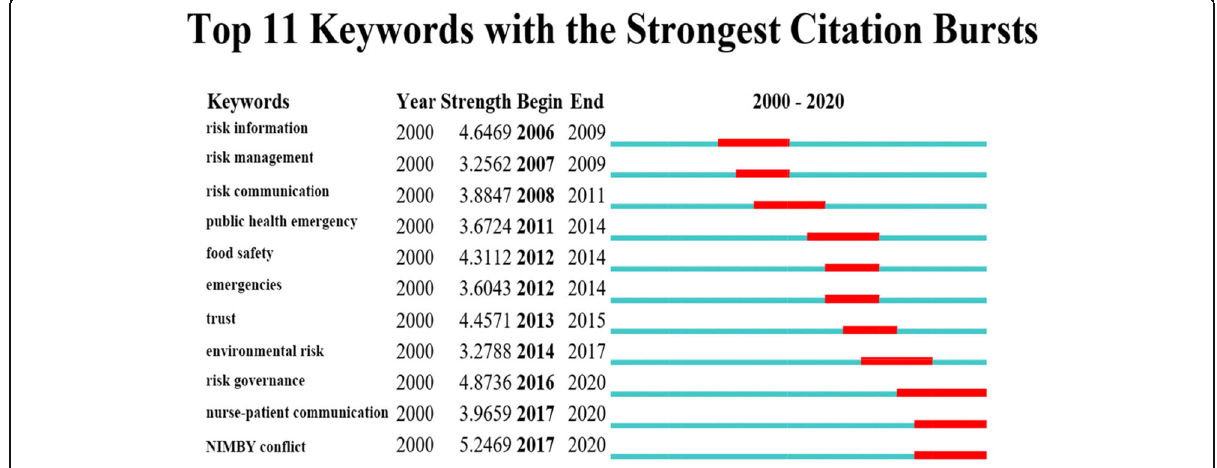
Fig. 7 Keywords with the strongest citation bursts of Chinese